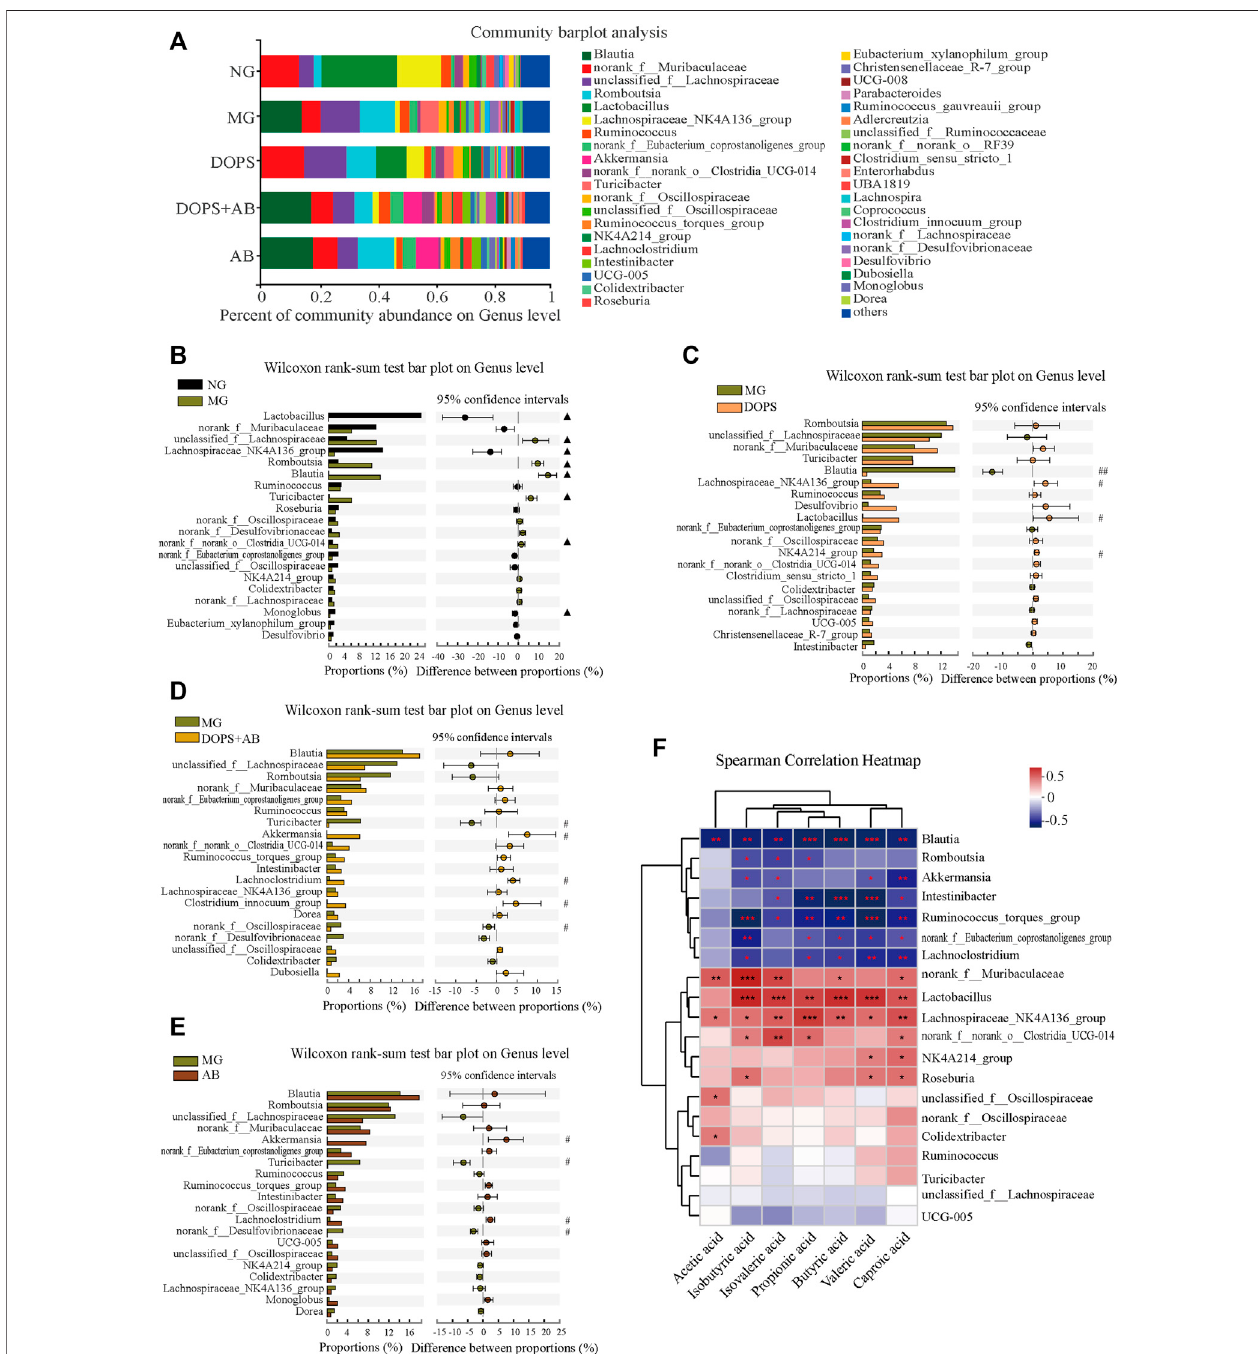
FIGURE8| EffectofDOPSonthegenuslevelofintestinal fl oraandthecorrelationwithSCFAsintheMHrats. (A) Percentofcommunityabundanceongenuslevel. (B – E) Analysisofthedifferenceofthetop20ofintestinal fl oraabundancebetweenNGandMG,MGandDOPS,MGandDOPS+AB,andMGandABongenuslevel. (F) Spearmancorrelation heatmapanalysisofintestinal fl ora composition andshort-chainfatty acids(SCFAs)on genuslevel.NG,normal controlgroup; MG, model control group; DOPS, Dendrobium of fi cinale polysaccharide; DOPS + AB, Dendrobium of fi cinale polysaccharide + antibiotics; AB, antibiotics. Compared with the normal control group, ▲ p < 0.05 and ▲▲ p < 0.01; compared with the model control group, # p < 0.05 and ## p < 0.01; the correlation * p < 0.05, ** p < 0.01, and *** p < 0.001 ( n = 3 – 4).